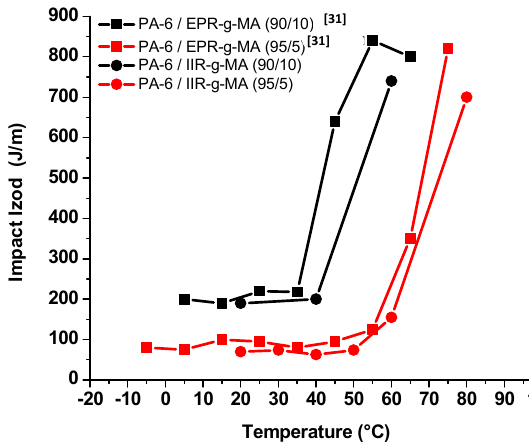
Figure 5. Izod impact strength as a function of temperature for binary blends at two IIR- g -MA contents (5% and 10%) where the continuous phase is PA-6. A comparison is also shown with data previously published for binary blends of PA-6 with EPR- g -MA as modifier [31] .